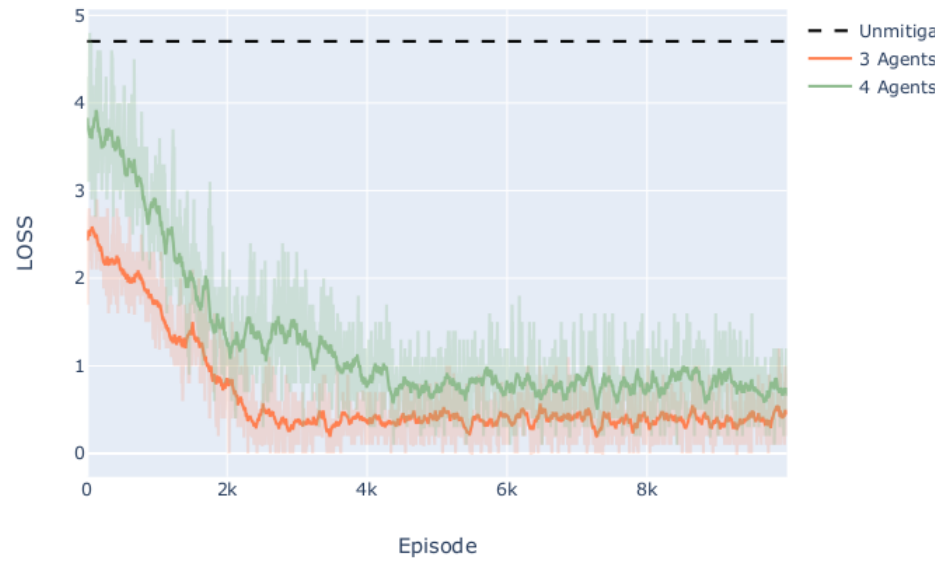
Figure 2. Number of losses of separation in comparison with average unmitigated case.